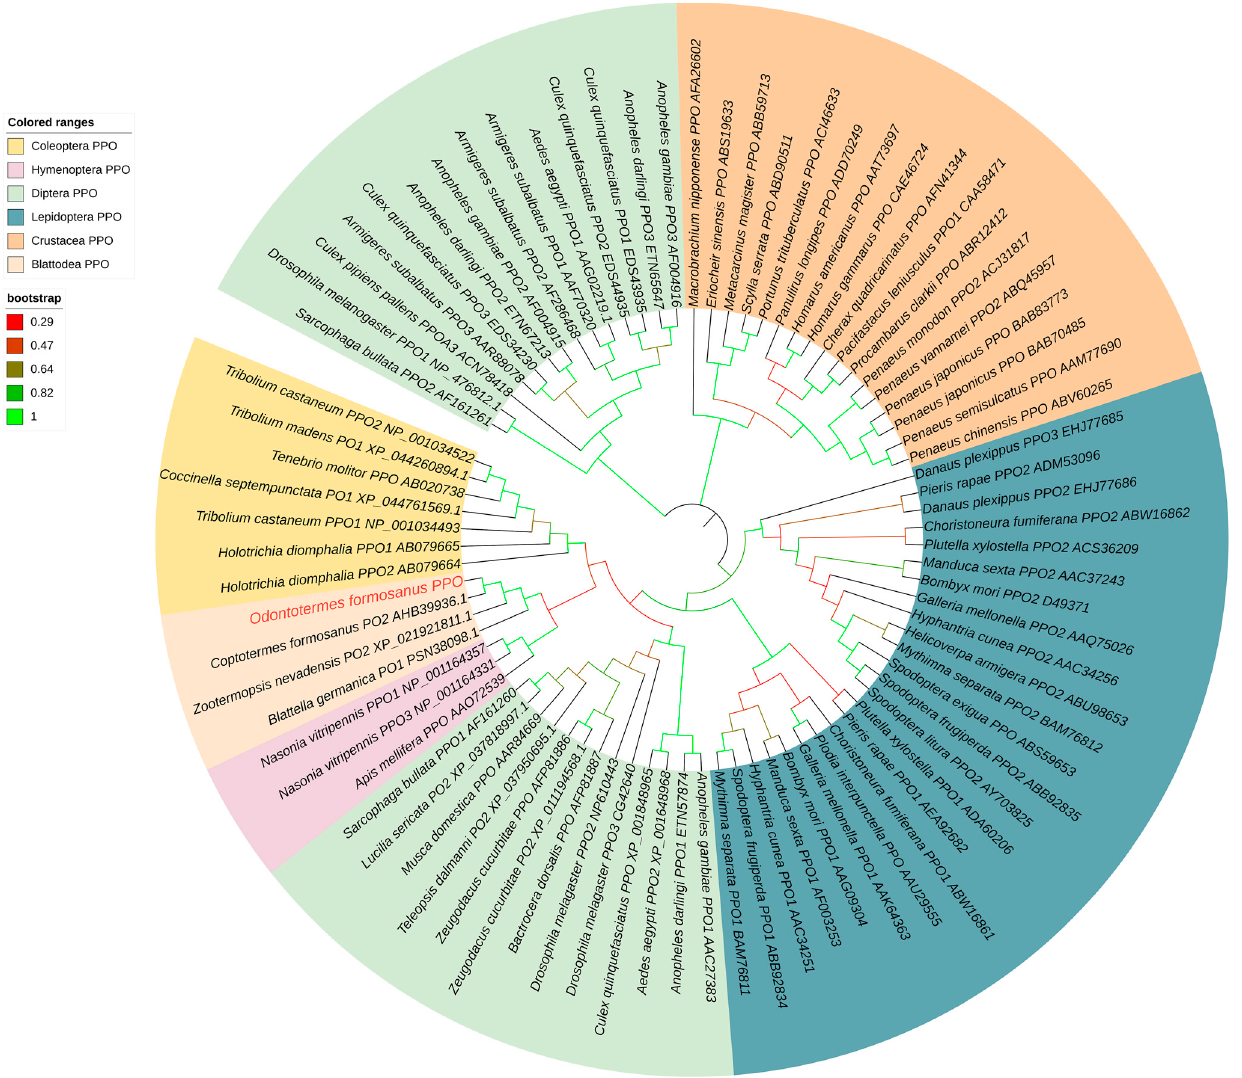
Figure 3. Phylogenetic analysis of the protein sequences of 82 PPOs, including 38 insects and 16 crustaceans. The PPO gene name was shown as the Latin name of the species, and the NCBI gene accession number was added. The O. formosanus PPO was marked in red. The branches specific for Lepidoptera, Blattodea, Coleoptera, Hymenoptera, Crustacea, and Diptera PPOs were shaded in different colors. Branch colors represent bootstrap values.